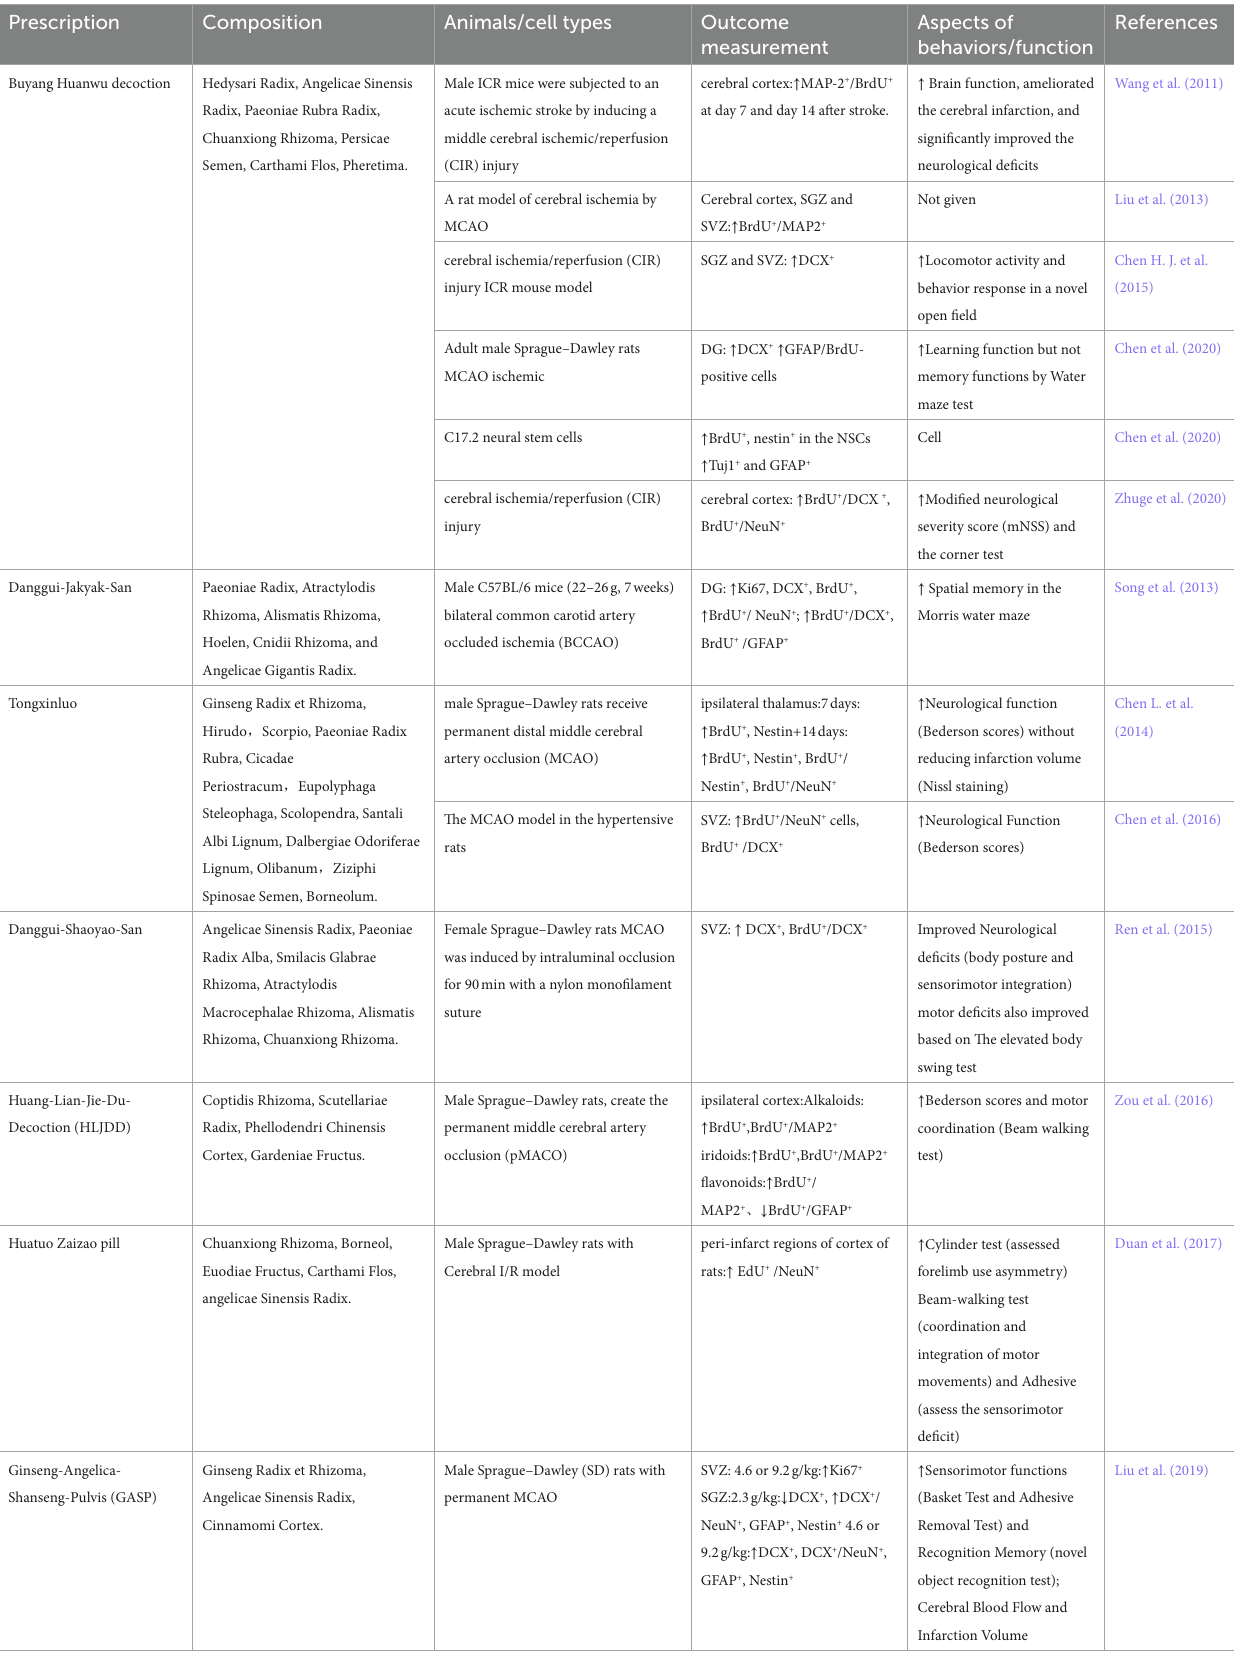
TABLE 1 Effects of TCM prescriptions on neurological conditions and adult neurogenesis.